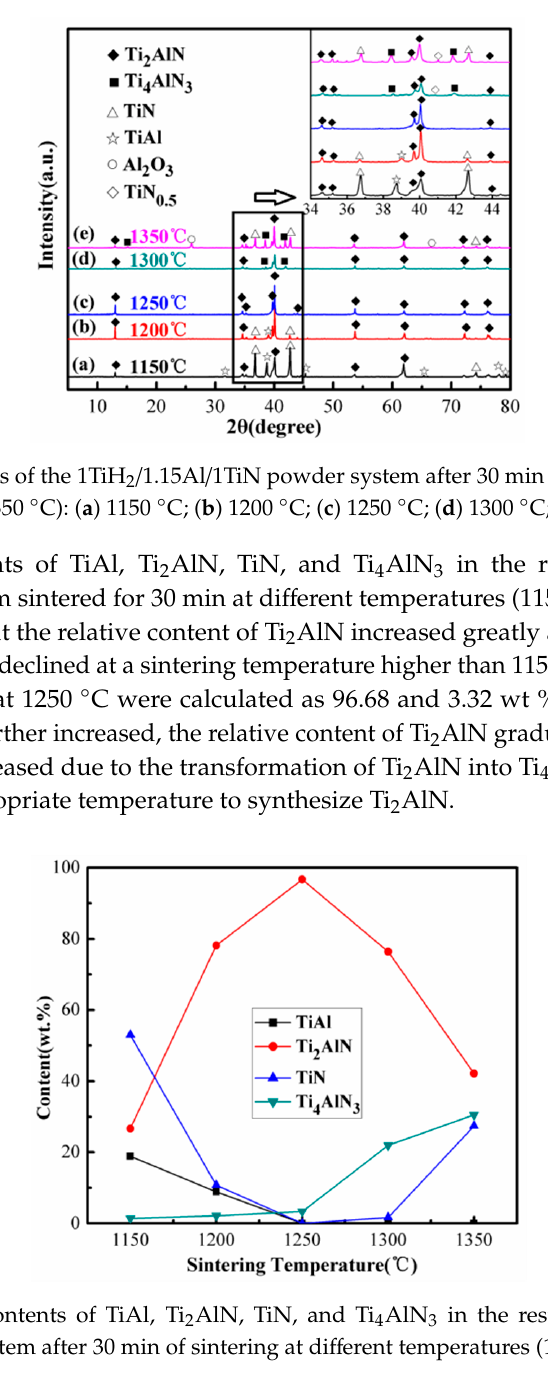
Figure 7. Relative contents of TiAl, Ti 2 AlN, TiN, and Ti 4 AlN 3 in the resultant products of the 1TiH 2 /1.15Al/1TiN system after 30 min of sintering at different temperatures (1150–1350 °C).